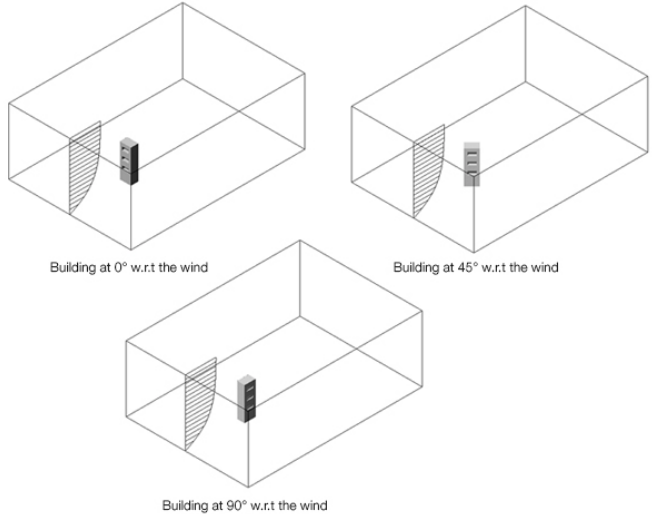
Figure A1. Three different orientations of the building with respect to the inlet wind direction.